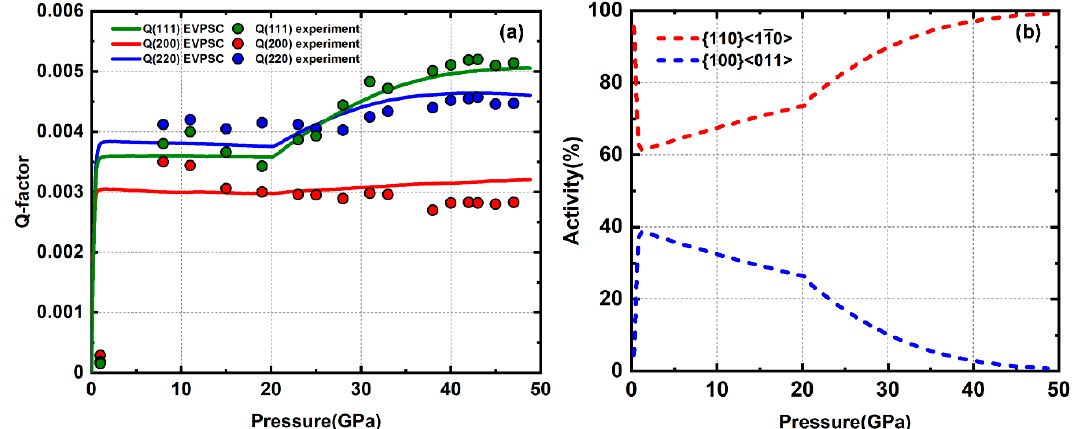
Figure 3. Inverse pole figures (IPF) of experimental and modeled textures of pure NaCl. Scale bar is given in multiples of random distribution (m.r.d.)